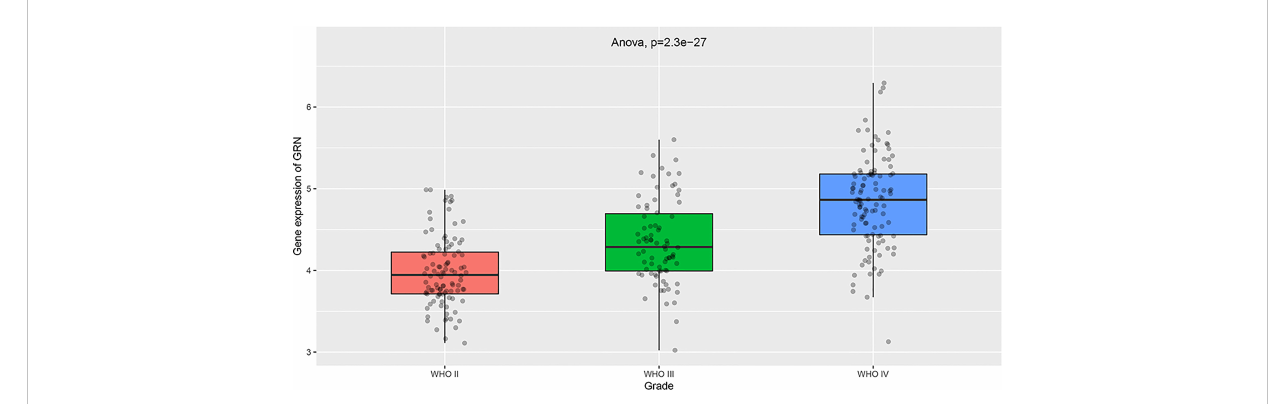
FIGURE 2 Differential expression of GRN in different cancer grade. (Based on the information of 103 G2 patients, 79 G3 patients and 139 G3 patients in TCGA database).